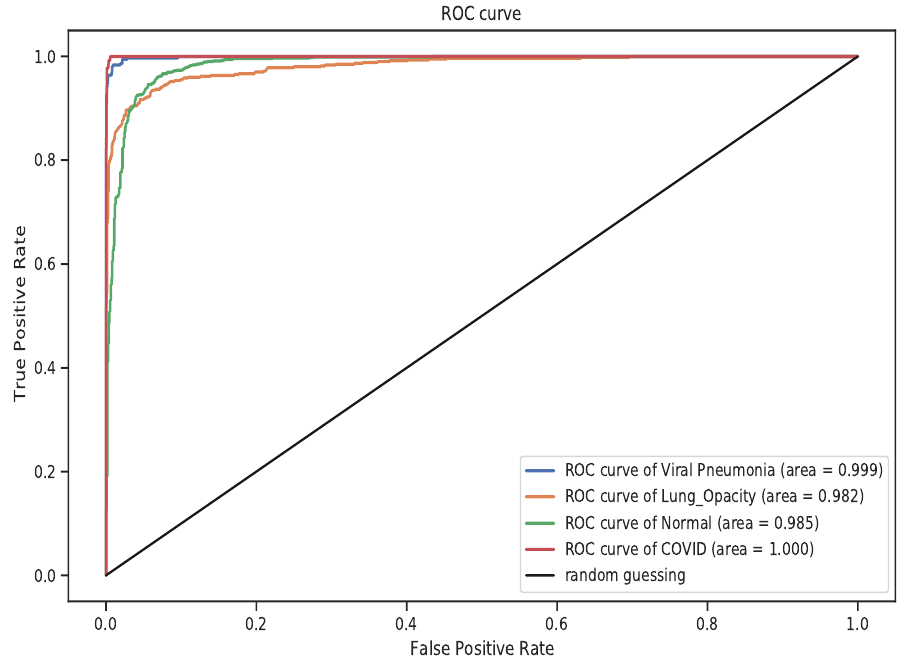
Figure 20. The ROC curve for ResNet-50 model. The overall performance of the model for the four classes was excellent with COVID-19 class obtaining AUC of